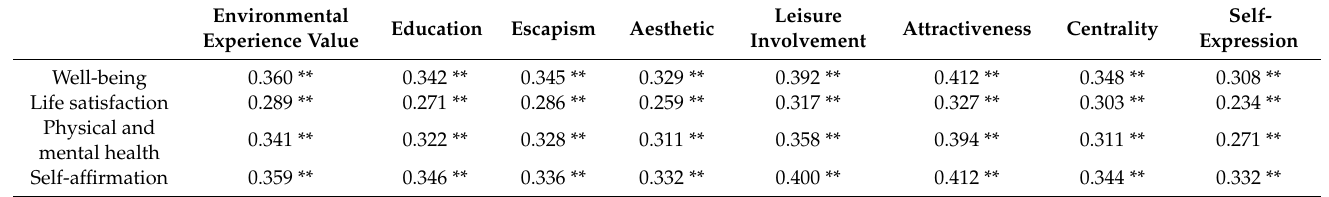
Table 4. Correlation analysis of environmental experience value, leisure involvement, leisure satisfac- tion, and well-being (environmental experience value and leisure involvement).